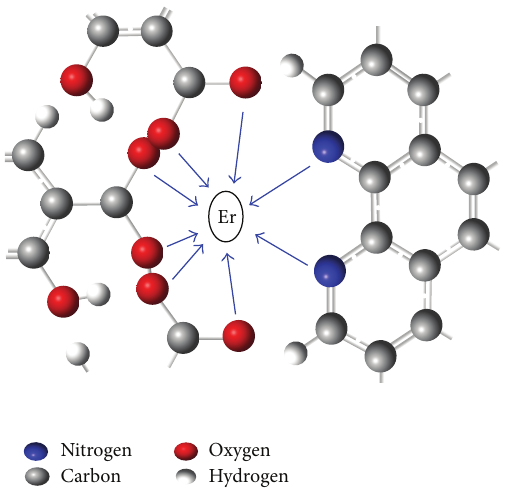
Figure 1: Molecular structure of Er-polymer